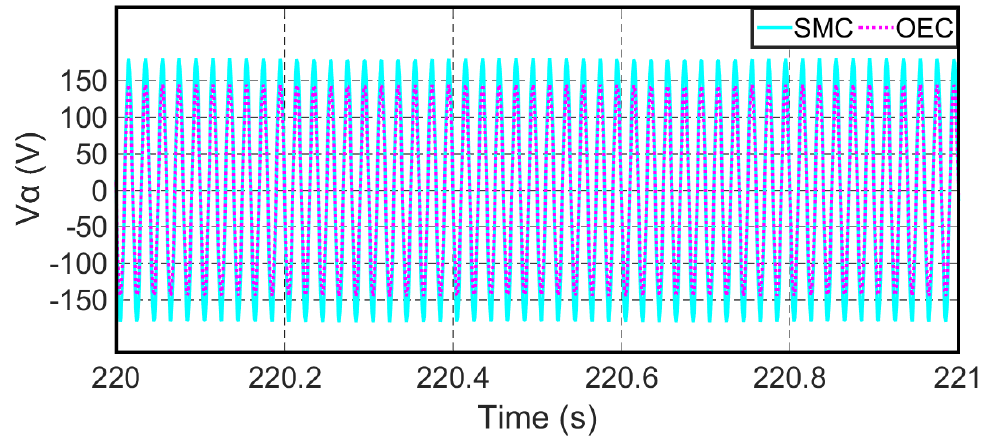
Figure 12. Experimental analysis: EV powertrain